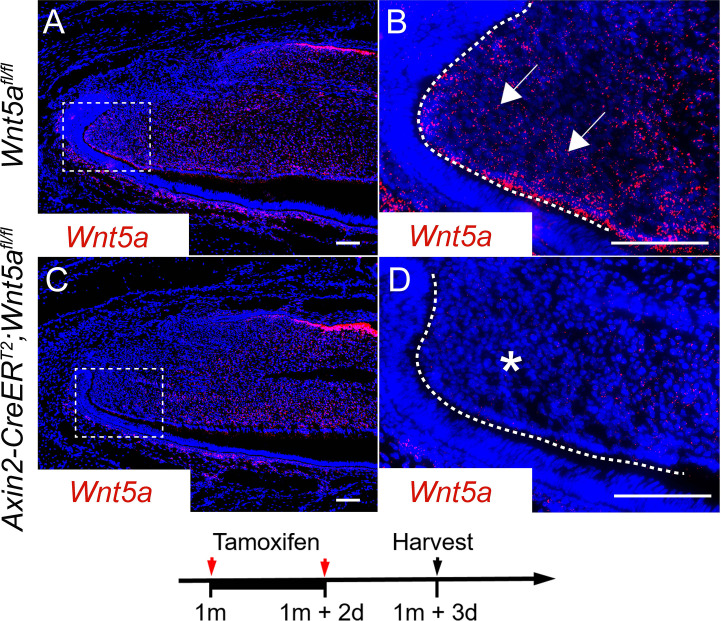
Validation of Wnt5a knockout efficiency in Axin2-CreERT2;Wnt5afl/fl incisors.(A–D) RNAscope (red) of Wnt5a in incisors from Wnt5afl/fl (control) and Axin2-CreERT2;Wnt5afl/fl incisors 3 days after tamoxifen induction. White arrow indicates positive signal and asterisk indicates diminished signal. Schematic at the bottom indicates induction protocol. Scale bars, 100 μm.